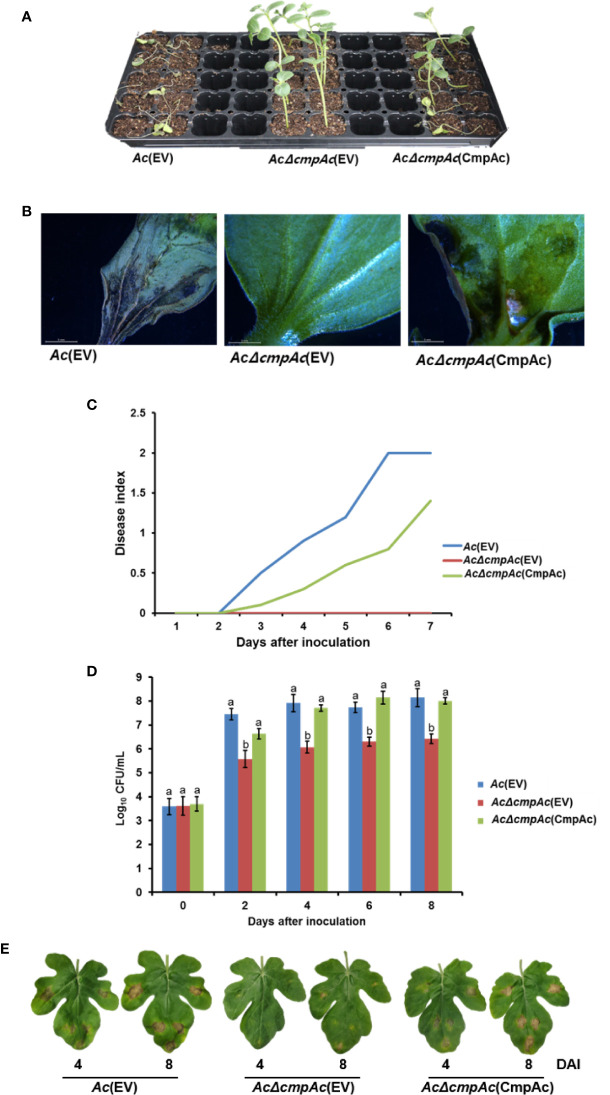
Pathogenicity assay for Ac(EV), AcΔcmpAc(EV), and AcΔcmpAc(CmpAc) using seed-germinated and infiltration inoculation method on watermelon. (A) The seed-germinated inoculation results in watermelon seedlings. The photographs were taken at 7 days after inoculation. (B) The midrib of infected leaves observed through a stereoscopic microscope. The observations were conducted 7 days after inoculation. (C) Disease index variation in the inoculated seedlings during 7 days after inoculation. The disease index is [Normal(numbers of plants)× 0+Spot(numbers of plants)×*1+Wilt(numbers of plants)×2]/Total(numbers of plants). (D) The bacterial population in the infected leaves for 8 days after inoculation determined by the colony counting method. The Ac strain suspension was adjusted to an O.D.600nm of 105 in 10 mM MgCl2, and then inoculated into first and second true leaves in 2-week-old watermelon seedlings using a needleless syringe. Different letters on error bars in the graph represent statistically significant differences by ANOVA (p < 0.05), Tukey HSDab. Error bars indicate standard errors of means. The graph was generated from seven independent experiments with three biological replicates. (E) The infected watermelon true leaf of each strain. The photographs were taken at 4 and 8 days after inoculation.